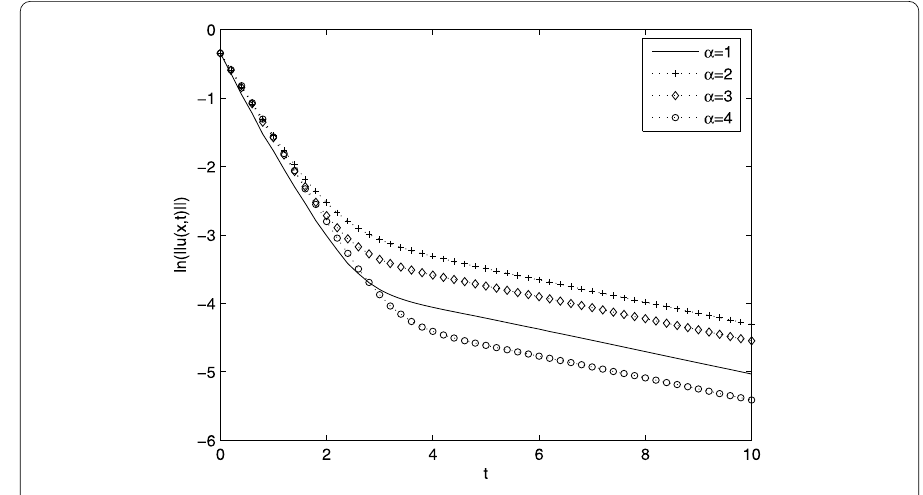
Figure 12 The natural logarithm of the L 2 -norm of u ( x , t ), ln( (cid:7) u ( x , t ) (cid:7) ), versus time for various values of α when using the second nonlinear non-adaptive control law; v = 0.01, μ = 0.001, γ 1 , γ 2 = 0.0005 and u